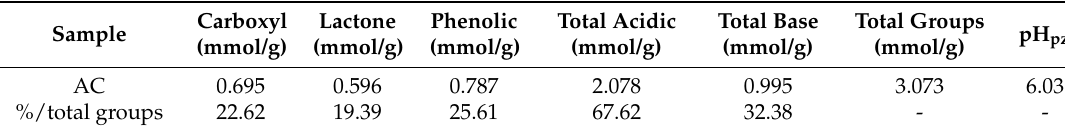
Table 3. pH pzc and concentrations of surface functional groups of AC.